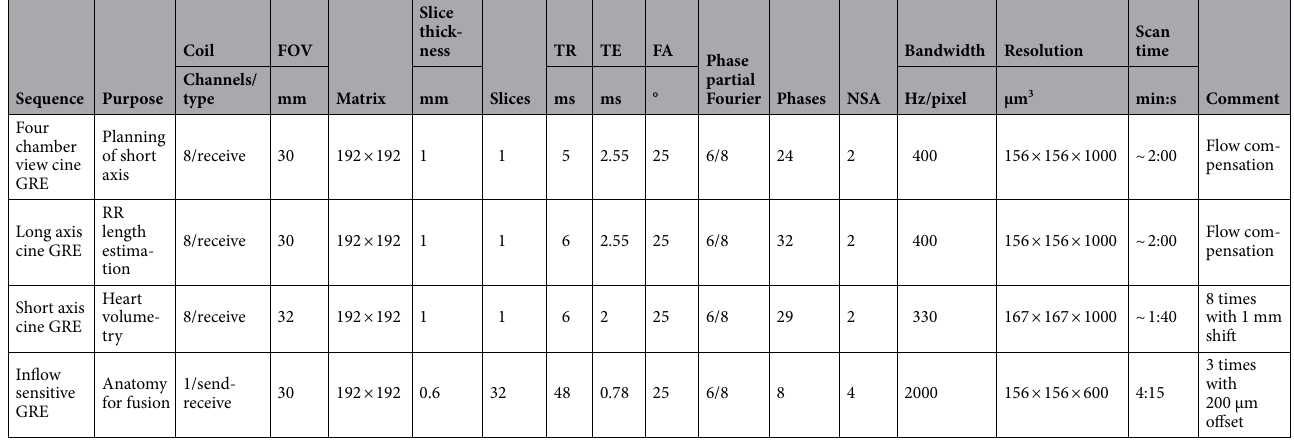
Table 1. MRI sequence protocol parameters: GRE—gradient echo, FOV—field of view, TR—repetition time, TE—echo time, FA—flip angle, NSA—number sum